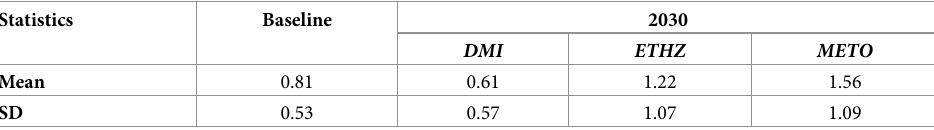
Table 3. Predicted mean and standard deviation of aflatoxin AfB1 concentration ( μ g/kg) in maize grown in Ukraine under baseline and projected future conditions for three climate models (DMI, ETHZ,